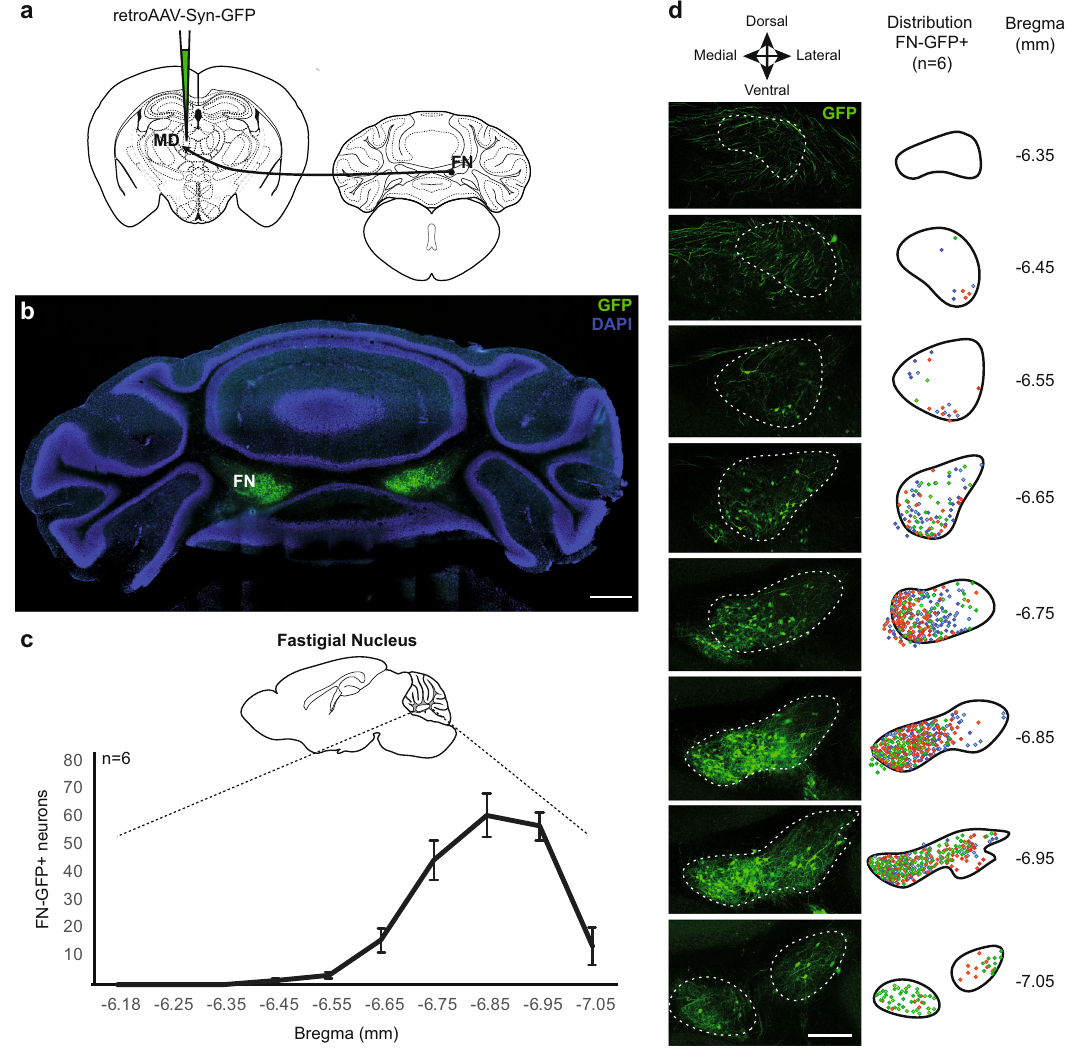
Fig. 1 | Cerebellar fastigial nucleus (FN) sends projections to the mediodorsal thalamic nucleus (MD). a Retrograde tracing strategy by injection of retrograde AAV-GFP in the MD. b Coronal cerebellar sections of FN with MD-projecting neu- rons expressing retrograde AAV-GFP (green), and cell nuclei labeled with DAPI (scale bar, 500 µ m). c Quanti fi cation (mean+/ − SEM) and antero-posterior dis- tribution of retrograde GFP-labeled FN MD-projecting neurons (FN-GFP+) in cor- onal sections (data from 6 mice). AP position is reported relative to Bregma.